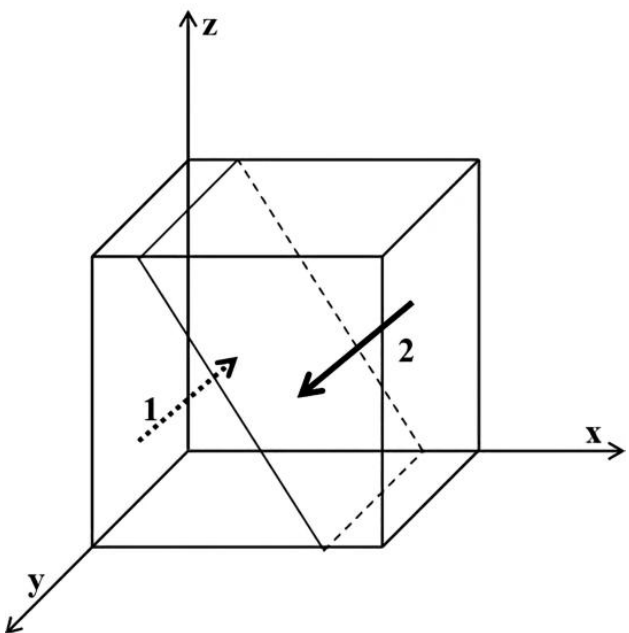
y . Region 1 is no